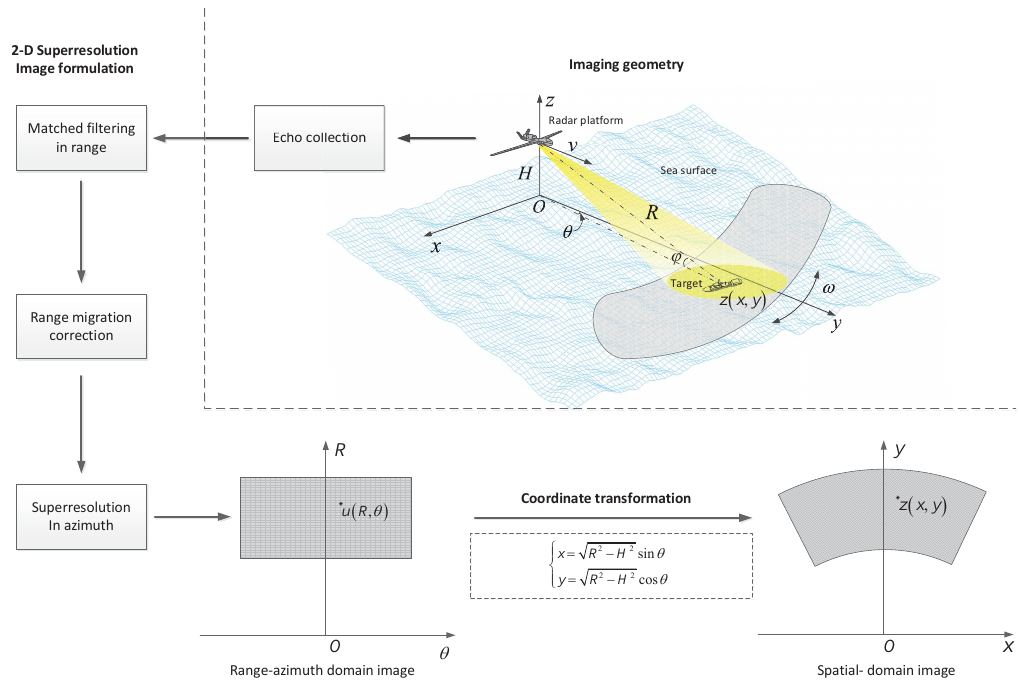
Figure 2. Geometry illustration for forward-looking scanning radar and the flowchart of imaging